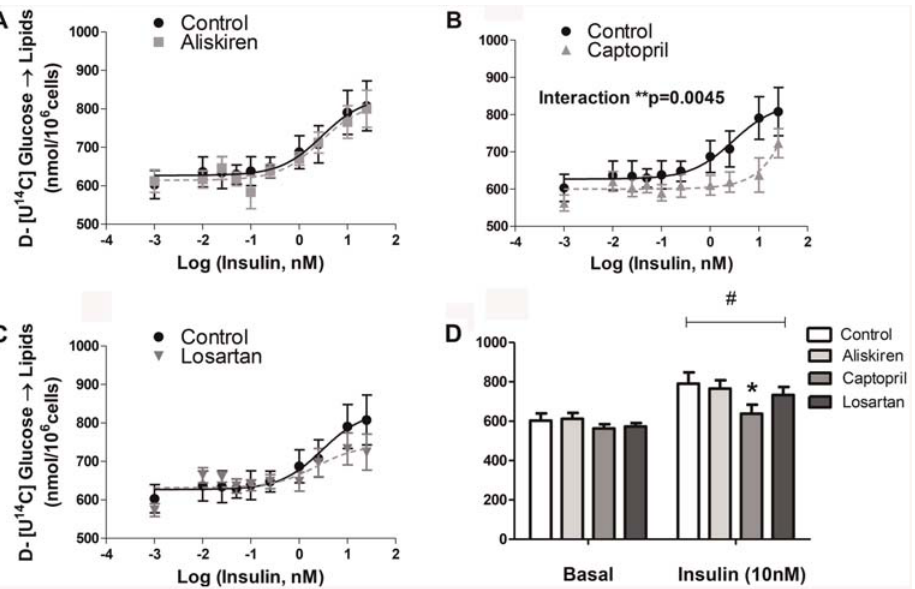
Figure 2. Lipid glucose incorporation of isolated fat cells previously treated with renin-angiotensin system blockers ( A ) aliskiren, ( B ) captopril and ( C ) losartan. Cells were incubated with increasing concentrations of insulin for 60 min at 37°C. D-(U- 14 C)-glucose (0.05 m Ci/tube) was added to the incubation medium at the beginning of the test. At the end, adipocyte lipid content was extracted, and the radioactivity incorporated in TAG was determined. D , basal and 10 nM insulin-stimulated lipogenesis. *P o 0.05 captopril vs control in 10 nM insulin-stimulated state. There was also signi fi cant lipogenic stimulus ( # P o 0.001 for basal vs 10 nM insulin). Data are reported as the mean ± SE (n=6). Two-way ANOVA and the Bonferroni ’ s post hoc tests were